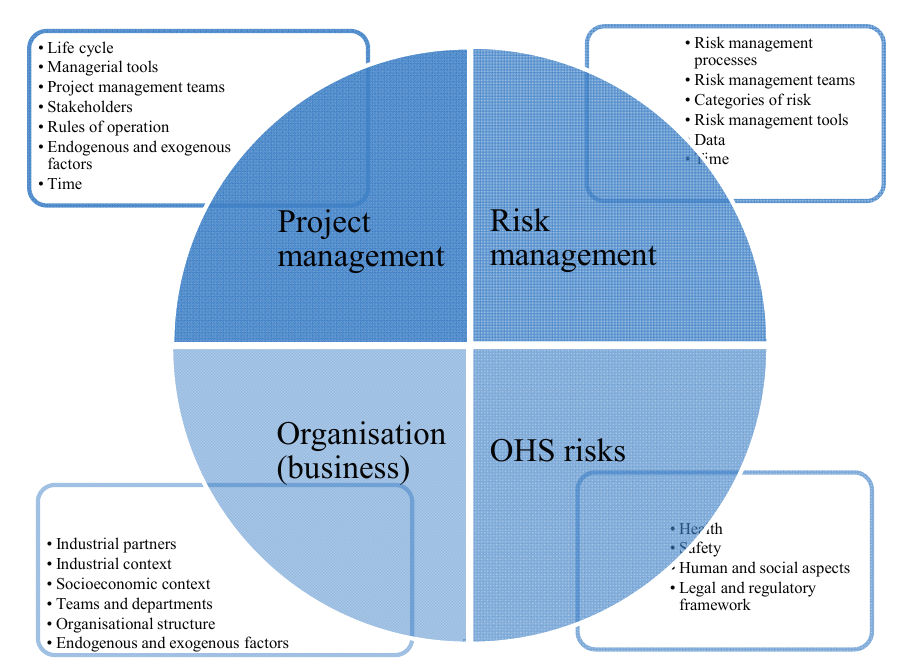
Figure 1. The four principal aspects of the OHS integration